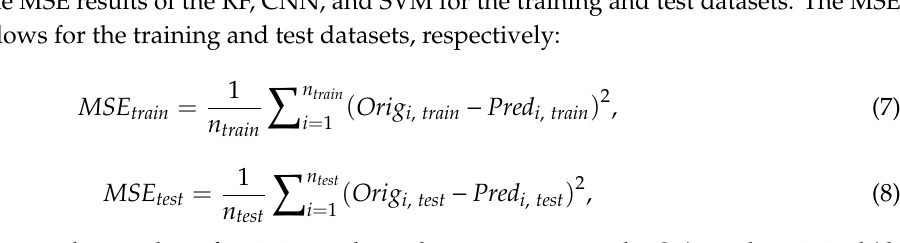
Figure 16. The training ( a ) and tests ( b ) results from the SVM.